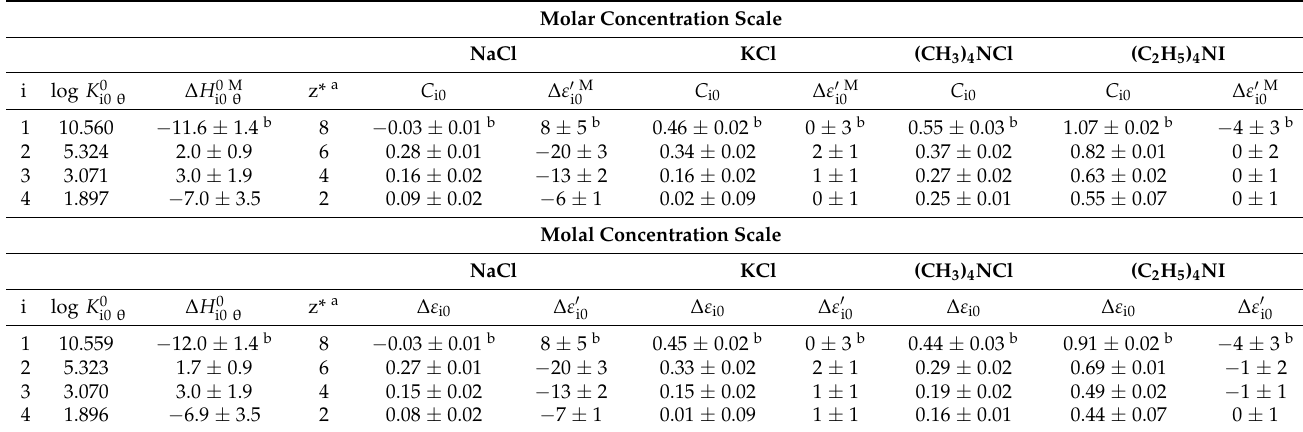
Table 3. Parameters obtained fitting experimental protonation constants to Equation (17) in the molar concentration scales at T = 298.15 K and p = 0.1 MPa.